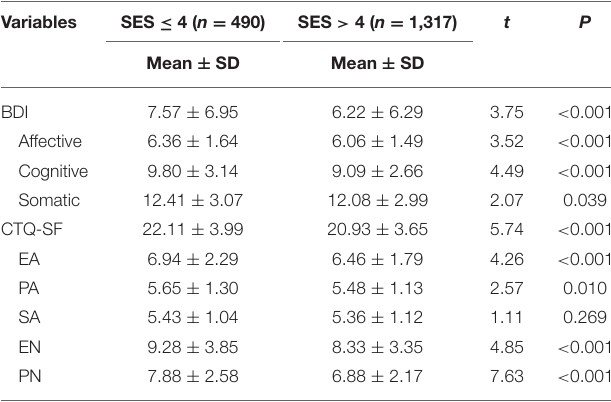
TABLE 1 | Differences between high SES and low SES participants on depressive symptoms and childhood trauma.